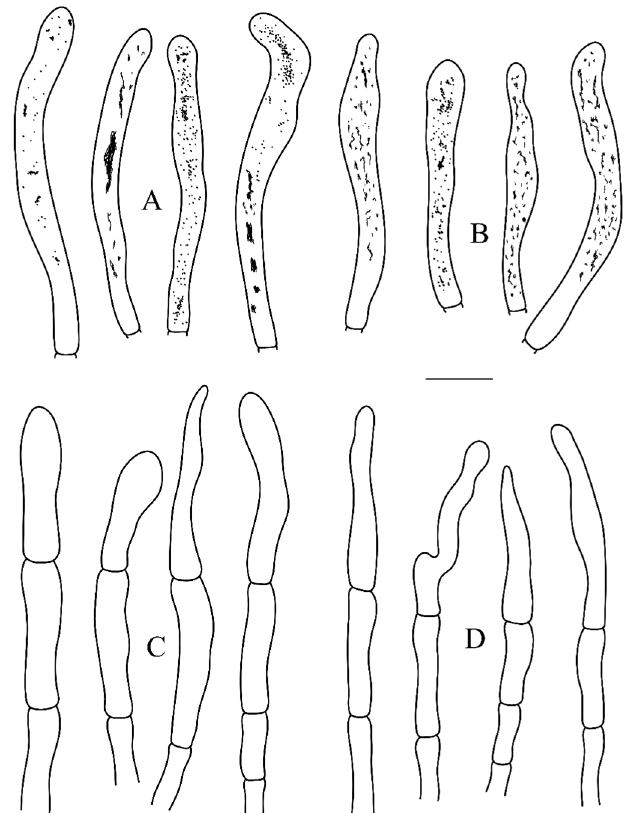
Figure 7. Russula callainomarginis (RITF2639). ( A ) Pileocystidia near the pileus margin. ( B ) Pileocys- tidia near the pileus center. ( C ) Hyphal terminations near the pileus margin. ( D ) Hyphal terminations near the pileus center. Scale bar: ( A – D ) = 10 µ